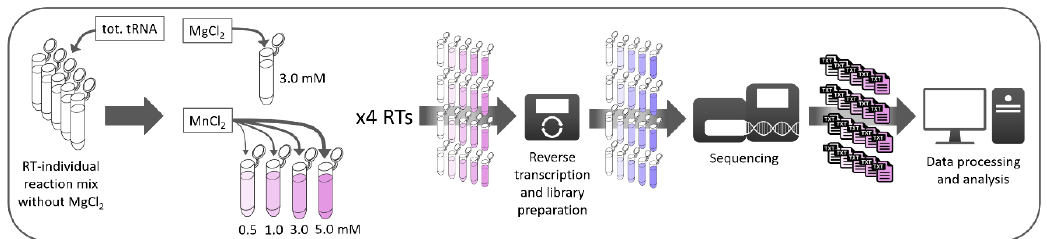
Figure 1. Overview of the sample preparation, comprising individual reaction mixtures for every transcriptase and addition of either MgCl 2 (reference) or four concentrations of MnCl 2 , thereby resulting in a total of 20 distinct reaction conditions.